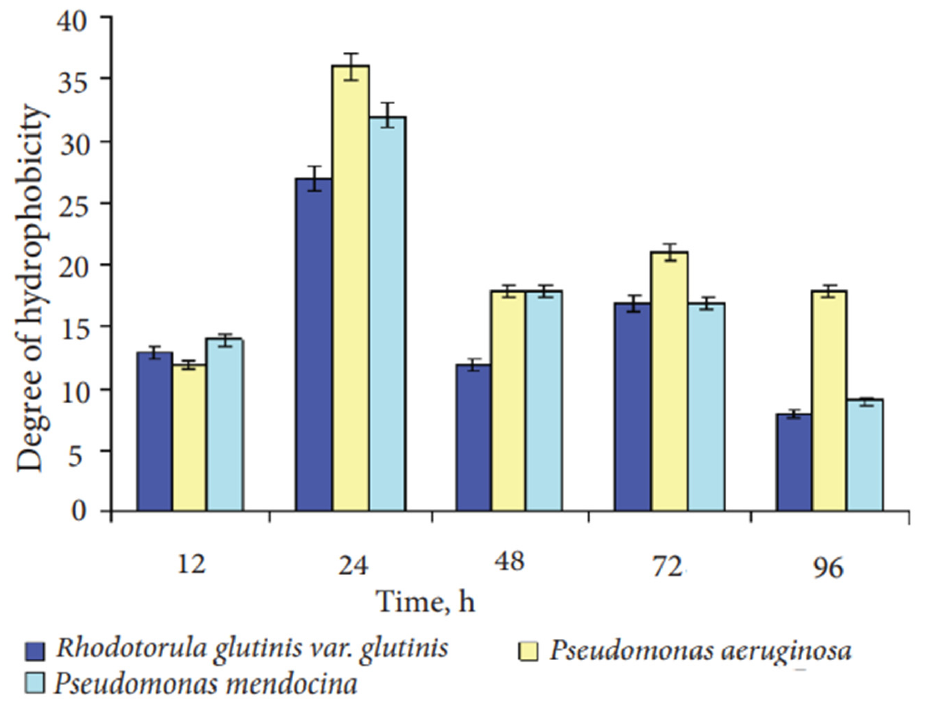
Figure 15. Changes in the hydrophobic properties of microbial cells during their cultivation on solid medium. Reprinted with permission from Ref. [50]. Copyright 2020, Jenny Stanford Publishing Pte. Ltd.